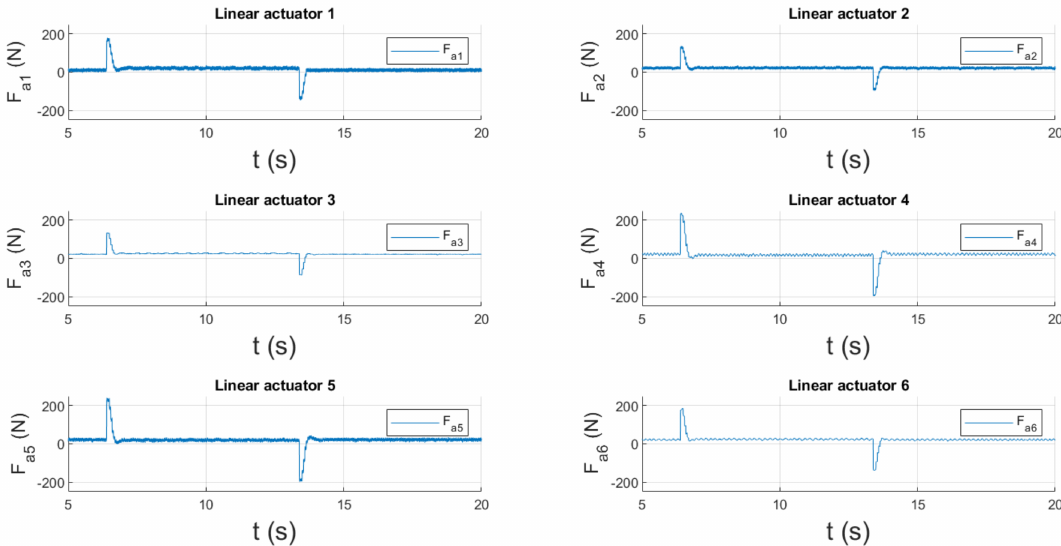
Figure 19. Acting forces of the Stewart platform linear actuators